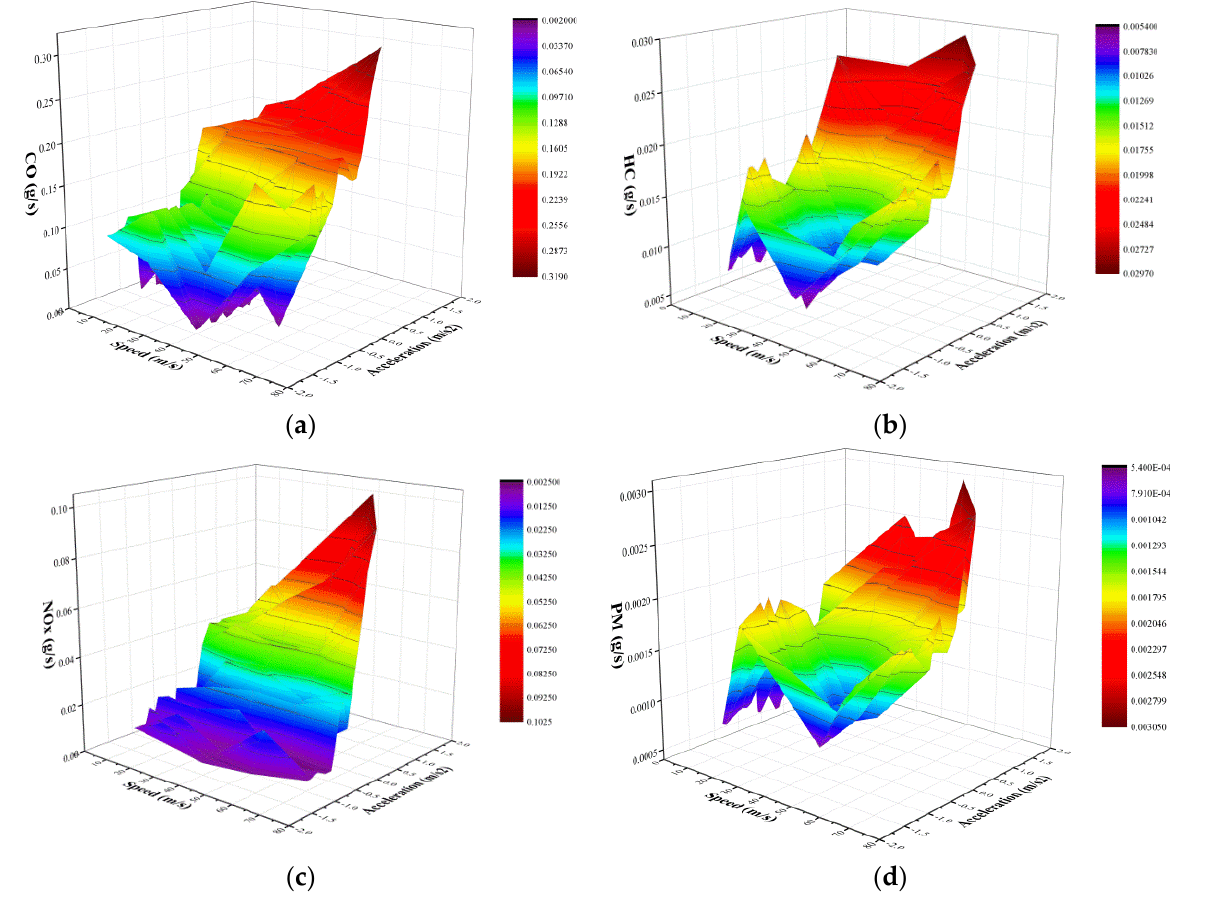
Figure 6. The typical relationship between vehicular speed, acceleration and pollutant emission rate; ( a ) Relationship between vehicular speed, acceleration and CO emission rate; ( b ) Relationship between vehicular speed, acceleration and HC emission rate; ( c ) Relationship between vehicular speed, acceleration and NOx emission rate; ( d ) Relationship between vehicular speed, acceleration and PM emission rate